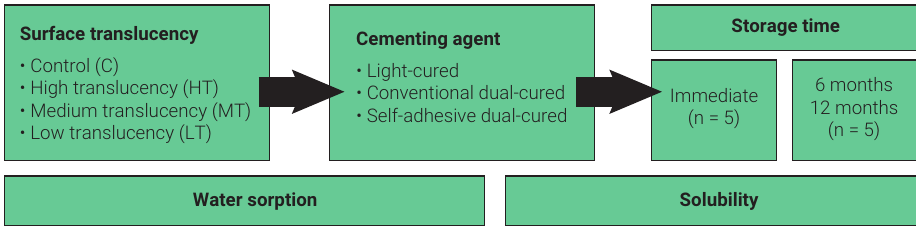
Figure 1. Distribution of Groups for water sorption and solubility